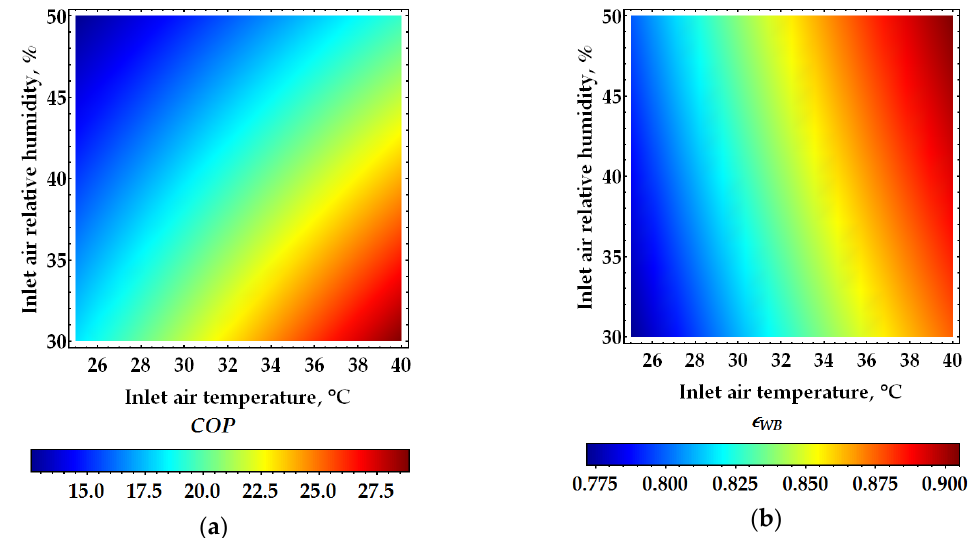
Figure 7. Contour plot of impact of inlet air temperature and relative humidity: ( a ) Coefficient of performance ( COP ) coefficient; ( b ) Wet bulb effectiveness.